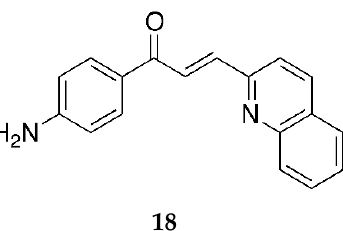
Figure 15. Chemical structures of the 4-aminochalcone derivate with a quinoline ring.